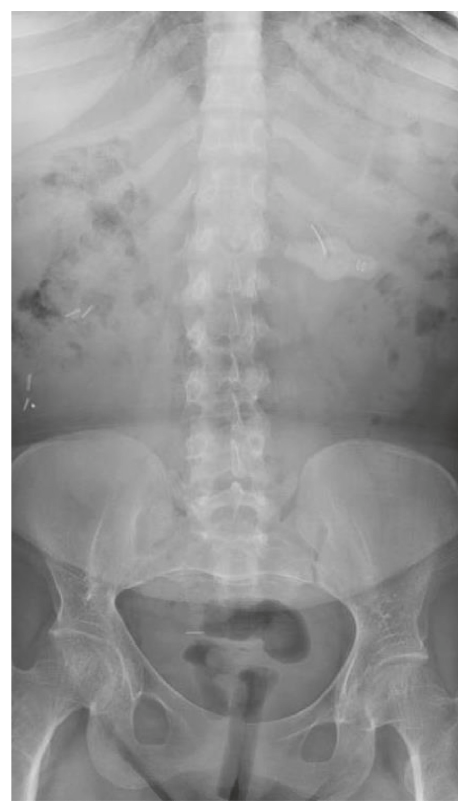
Figure 2: The patient demonstrated normal spine